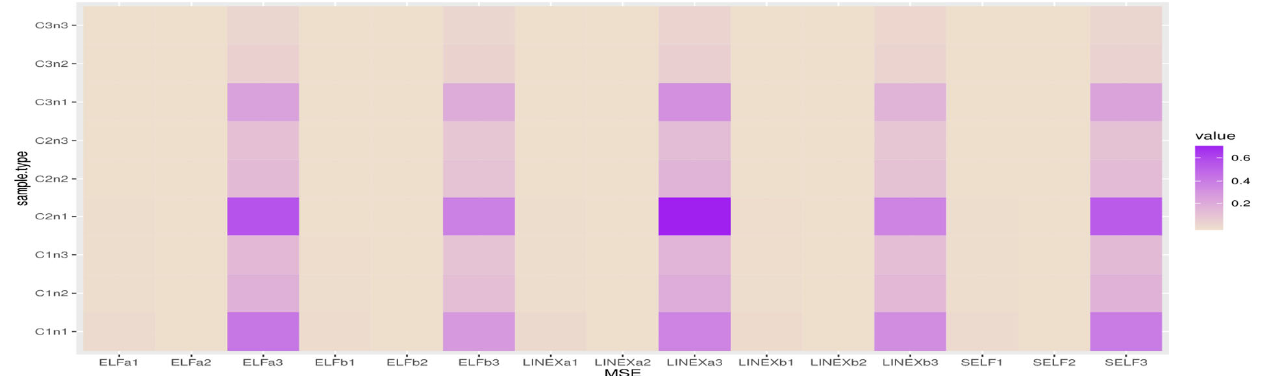
Figure 5. Heatmap for MSE when 𝑎 (cid:3404) 0.5, 𝑏 (cid:3404) 1.7 .